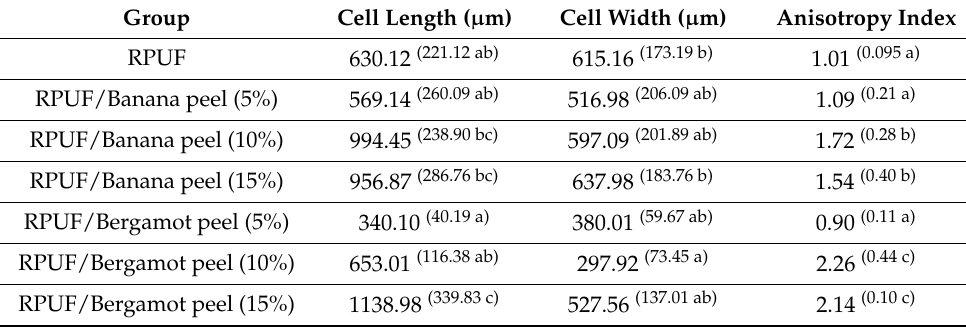
Table 1. Morphological properties of the studied RPUF.